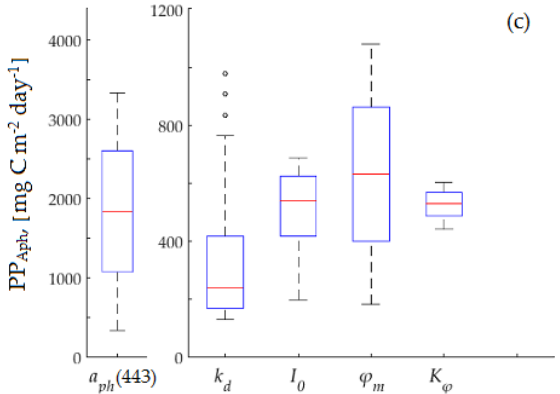
Figure 8. Box-whisker plots for the sensitivity analysis on ( a ) PP VGPM , ( b ) PP PSM , and ( c ) PP Aph : For the left hand y-axis, PP is from 0–4400 mg C m − 2 day − 1 ; right y-axis PP is from 0–1200 mg C m − 2 day − 1 . Chl 90 is the average Chl a concentration over the first optical depth, k d is the downwelling diffuse attenuation coefficient, I 0 is the daily surface PAR, P B opt is the biomass-specific optimum rate of photosynthesis, DL is the day length, P B m is the biomass-specific maximum rate of photosynthesis, α B is the initial slope of the P - I curve, a ph (443) is the coefficient of light absorption by phytoplankton at 443 nm, φ m is the maximum quantum yield of photosynthesis, and K φ is the half-saturation constant of the φ - I curve. The rectangular boundaries are the first and third quartiles (the 25th and 75th percentiles) of the modelled PP eu obtained by changing each parameter in turn. The line in the rectangle is the median (50th percentile) of the sample, the edges of the “whiskers” are the size of the sample (minimum and maximum of the sample), and the symbol, “o”, represents extreme values. The larger the size of the box and whiskers, the greater the contribution of the parameter to the variability in the modelled PP eu .